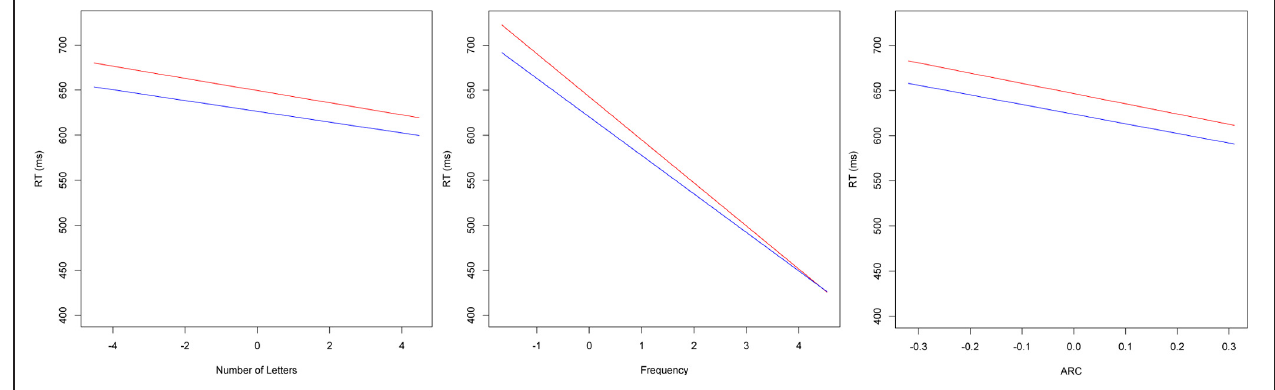
blocks. Note: Length, number of letters (centered); Frequency, log SUBTLEX frequency (centered); ARC, semantic neighborhood density